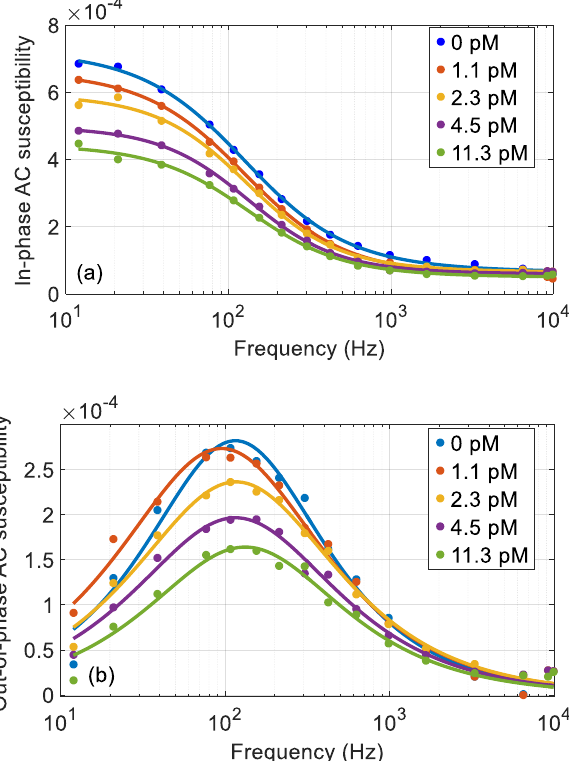
Figure 4. In-phase ( a ) and out-of-phase components ( b ) of the AC susceptibility (volume susceptibility) versus frequency at different RCA concentration as indicated in the figure panels. Measurements are performed at room temperature. The used MNPs have a constant particle concentration of 50 µg/mL for each RCA concentration. The solid lines are from fitting the data to a Cole-Cole function.